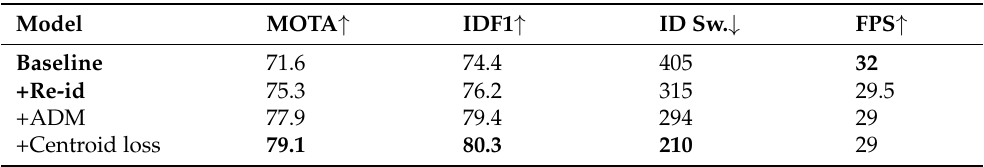
Table 3. The influence of different modules on algorithm performance. The best results are shown in